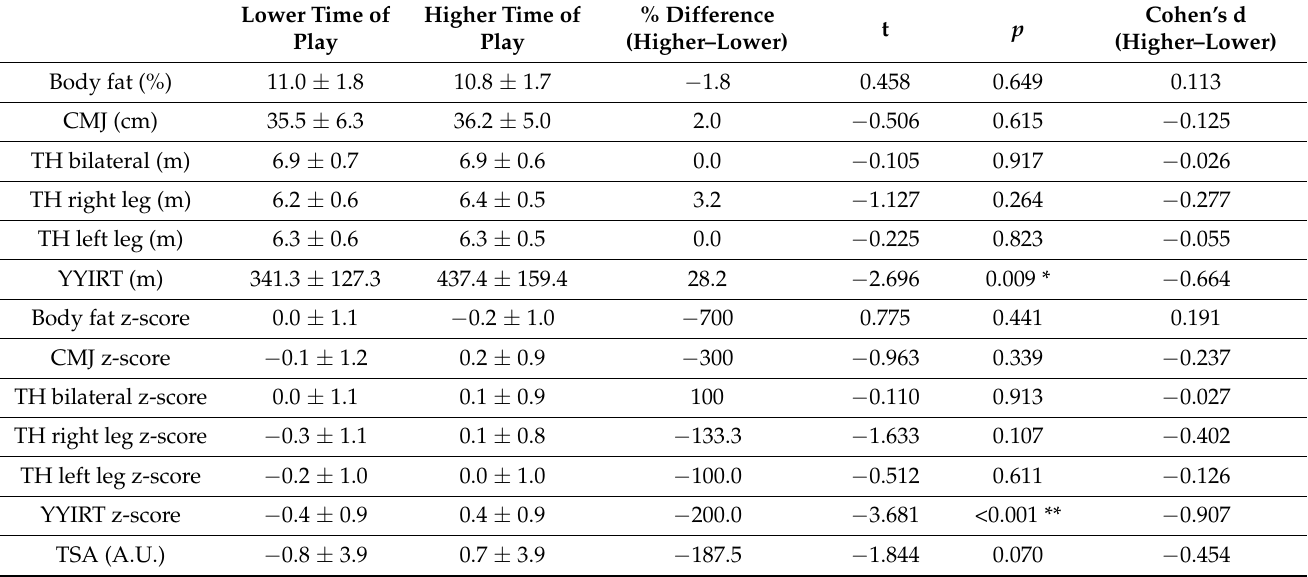
Table 2. Descriptive statistics (mean and standard deviation) of physical fitness outcomes for those with less and more play time.